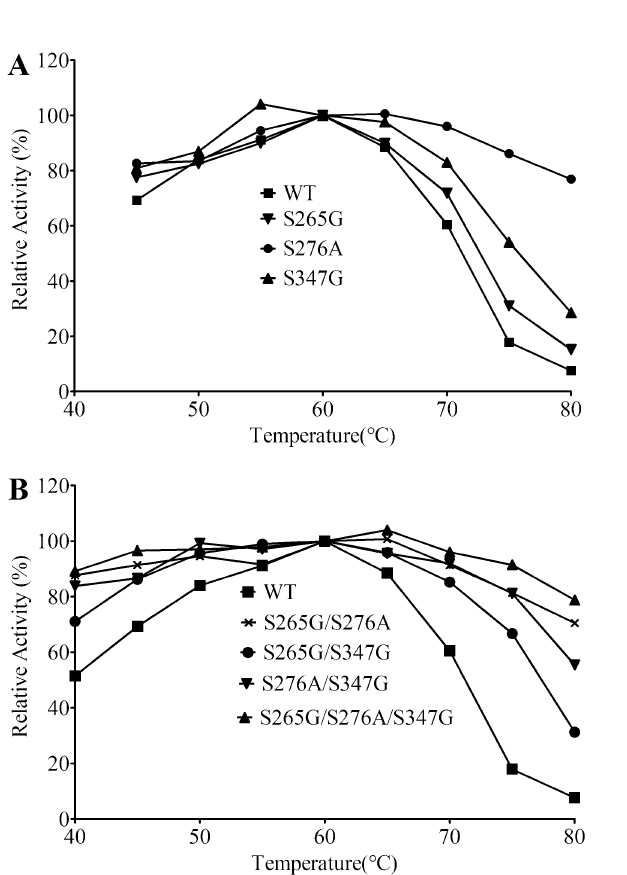
Figure 3. Temperature profiles of the wild-type enzyme and mutant variants. ( A ) The wild-type and single-site mutants. ( B ) the wild-type and multiple-sites